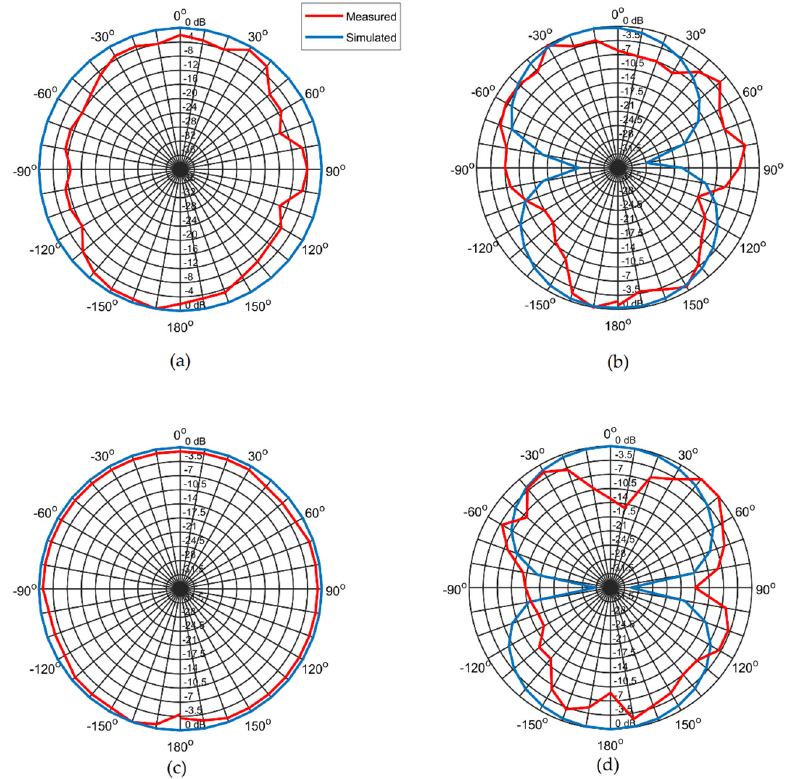
Table 4. Simulated (S) and Measured (M) Peak Gain.